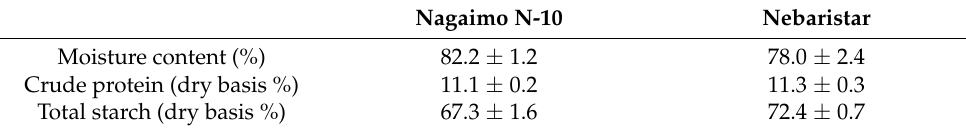
Table A1. Moisture content, crude protein and total starch of the two samples.